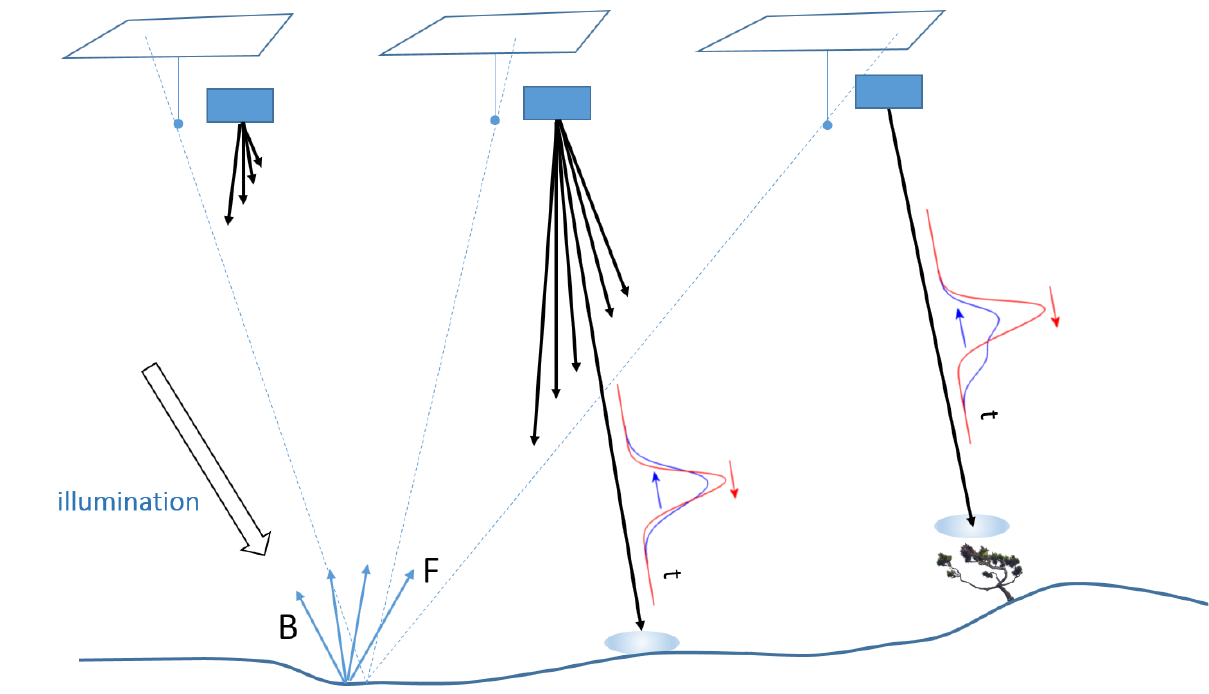
Figure 2. Illustration of ‘sensor fusion on the bog surface’. Airborne camera and LiDAR are operated concurrently such that the same surface patch is seen in several images (exposed at short intervals) and is sampled densely by LiDAR. The return waveform (blue) preserves its shape when sampling well-defined surfaces, while a tilted or rough surface or volumetric vegetation extends it. When the camera is moving, image observations are influenced by directional reflectance properties of the targets as the view direction (camera-target ray) changes. B = backscattering, F = forward-scattering